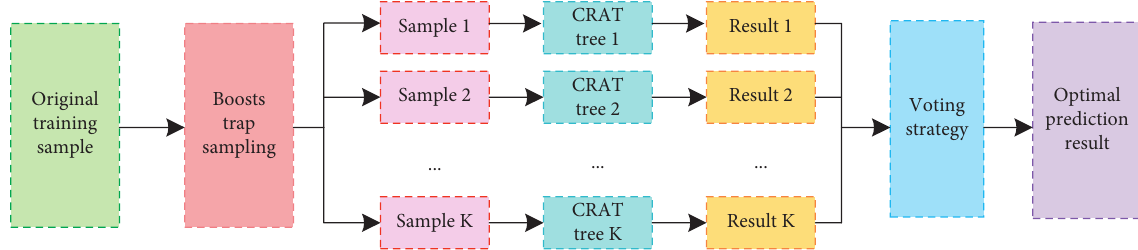
Figure 3: Flowchart of the proposed